Question: Does the figure show an increasing or a decreasing trend?
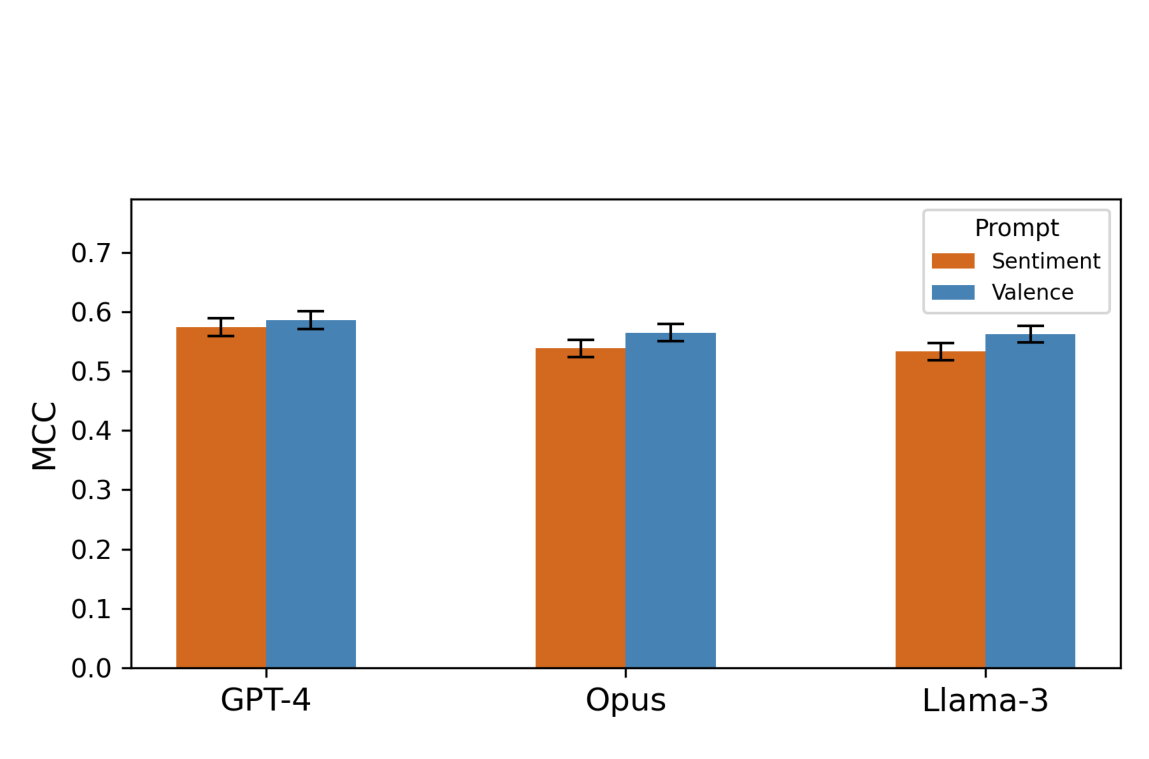
Answer: increasing